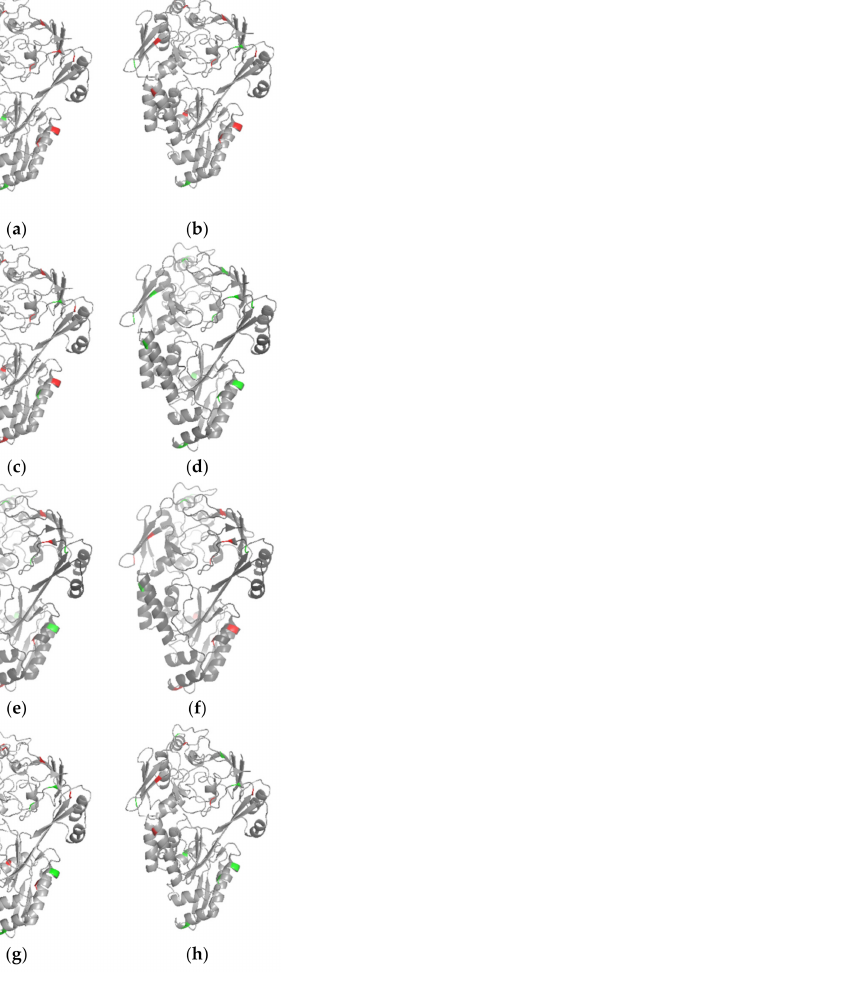
Figure 7. Visualization comparisons of various classifiers on protein P23847: ( a ) iSuc-PsaAAC; ( b ) pSuc-Lys; ( c ) HybridSucc; ( d ) SuccinSite; ( e ) DeepSuccinylSite a ; ( f ) DeepSuccinylSite b ; ( g ) iSuc- PseOpt; ( h ) our